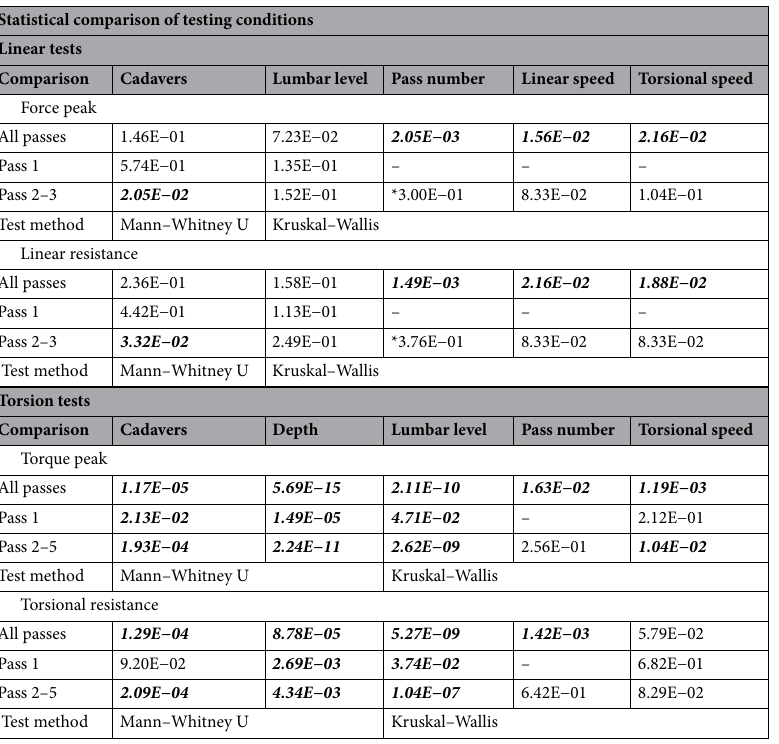
Table 3. Statistical comparisons of testing conditions. All bolded, italicized values have significance p ≤ 0.05 and exceed the JND threshold of 7%. *Performed with Mann–Whitney U